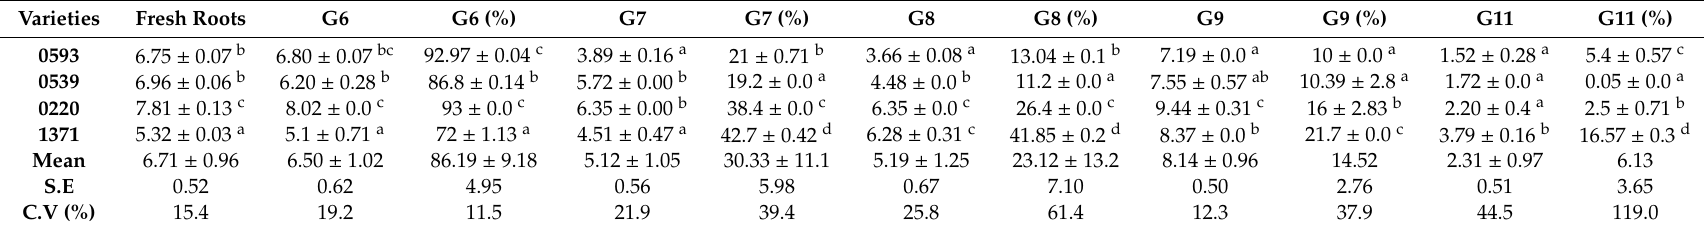
Table 2. β -Carotene ( µ g / g) concentrations (fresh weight basis) and their percentage true retention of cassava products from Yellow Cassava varieties (three-day fermentation)